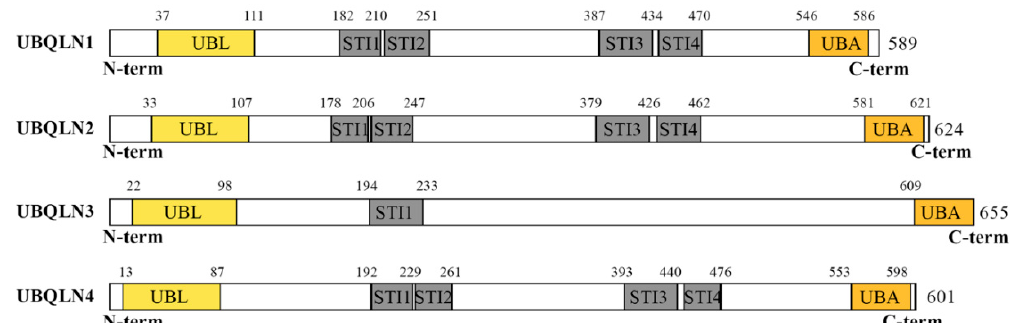
Figure 1. Structural organization of human ubiquilins (UBQLNs). The figure depicts the functional domains of major UBQLNs (UBQLN1-4) that have been functionally linked to human diseases. Structural analyses of the UBQLN proteins were performed using the integrated tool InterProScan (available online at https://www.ebi.ac.uk/interpro/). UBQLN1, UBQLN2 and UBQLN4 proteins have very similar UBA and UBL domains, encode structurally identical proteins containing four STI domains and are related by successive duplications [7]. In contrast, UBQLN3 carries a single STI domain and has been proposed to be more evolutionary divergent. UBL: Ubiquitin-like domain; STI: STress Inducible proteins or Hsp70–Hsp90 organizing protein; UBA: Ubiquitin associating domain.